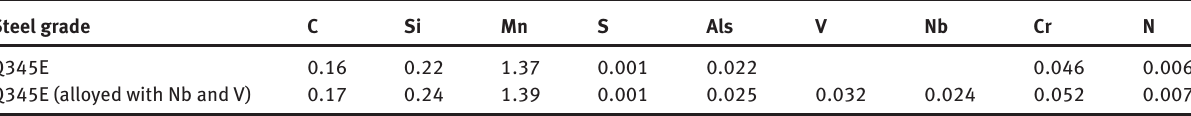
Table 1: Basic chemical composition of Q345E steel Steel grade